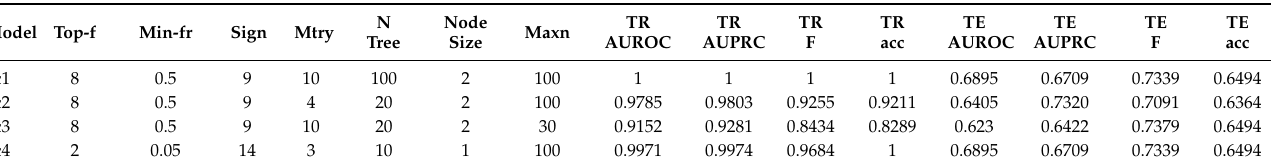
Table 4. Best Random forest models trained on the clinical data.